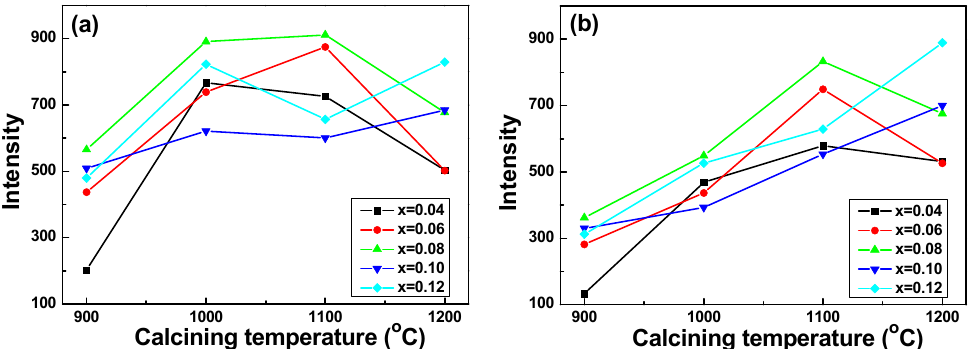
Figure 4. Emission intensity of Sr 2 − x Eu x ZnMoO 6 phosphors as a function of synthesizing temperature. ( a ) Emission peak of 597 nm; and ( b ) emission peak of 616 nm. The transitions of 5 D 0 – 7 F 1 (588 nm), 5 D 0 – 7 F 2 (612 nm), 5 D 0 – 7 F 3 (649 nm), and 5 D 0 – 7 F 4 (695 nm) for